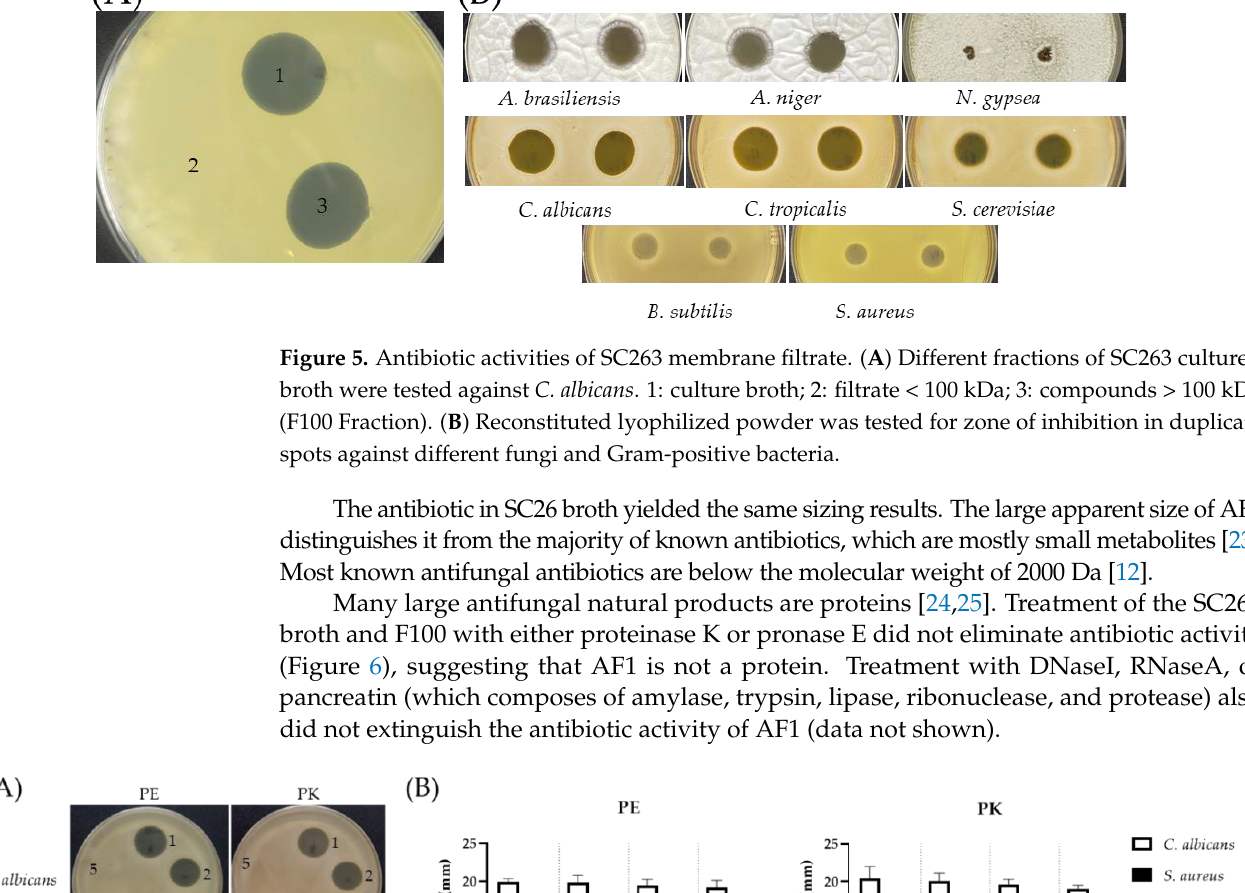
5 of 11 Figure 4. Antibacterial and antifungal activities of SC263. ( A ) Antibiotic activity of SC263 using cross-streak method for a 6-day incubation. An aliquot of 1 μL of bacterial suspension containing 10 3 CFU were spotted cross the central line of SC263. ( B ) 10 μL of SC263 culture suspension was spotted in quadruplicates on lawns of test fungi and bacteria. A. brasiliensis , A. niger , and N. gypsea , was seeded with 10 6 CFU each plate. The rest was seeded with 10 5 CFU. ( C ) The diameters of inhi- bition zones were measured in triplicate. The error bars are calculated based on the quadruplicate zones for each tested microbe. White columns indicate fungi and black as Gram-positive bacteria. 2.4. Characterization of the SC263 Antibiotics by Membrane-Filtration